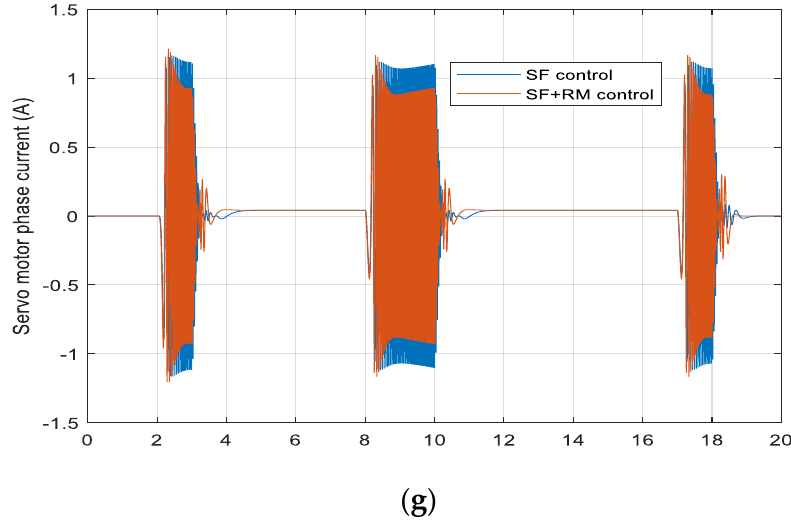
Figure 7. Simulation results at 2 m/s and 25 degrees steering input: ( a ) steering angle; ( b ) tilt angle; ( c ) actuator torque; ( d ) perceived acceleration; ( e ) yaw rate; ( f ) actuator power and battery energy consumption; and ( g ) servo motor phase current.